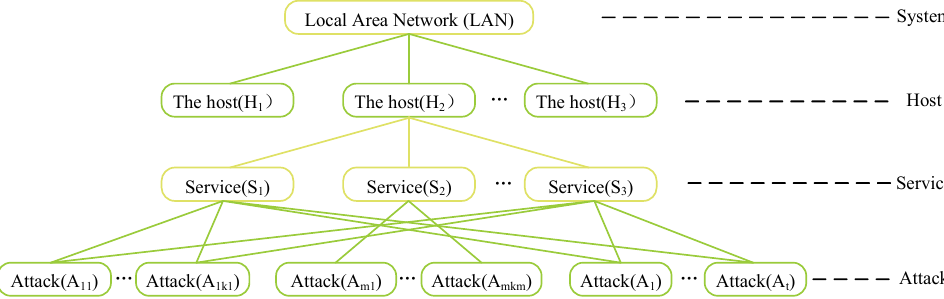
Figure 7. Hierarchical network system security threat situation quantitative assessment